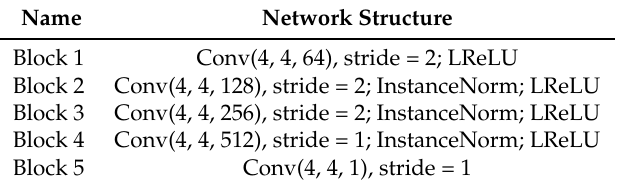
Table 2. Discriminators architecture.